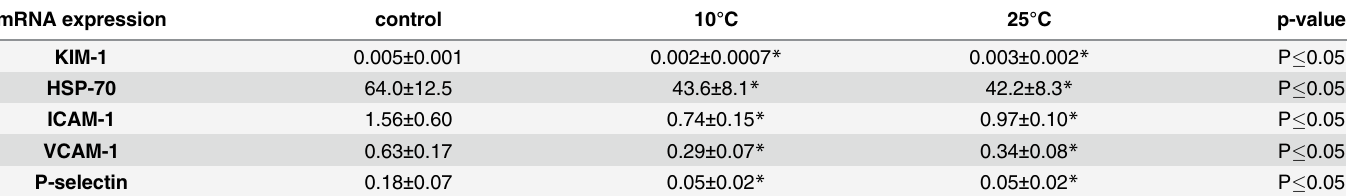
Table 5. mRNA expression level of KIM-1 and HSP-70 in the kidney biopsies specified by real-time PCR in the frozen sections from the control group and the gradual rewarming groups. * P < 0.05 vs control group. Values are mean ± standard deviation.